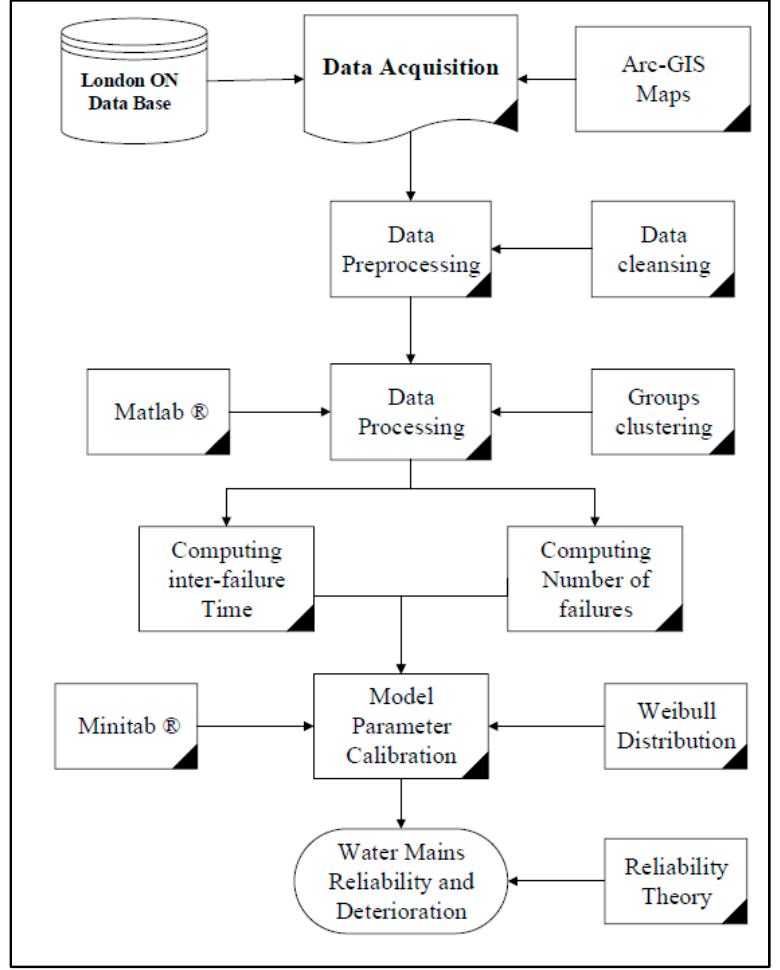
Figure 6. Flow diagram of reliability and deterioration estimation.